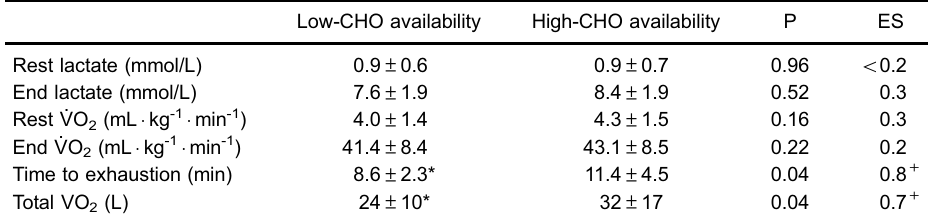
. Table 2. Values for lactate and VO 2 at rest and at the end of exercise, exercise time to exhaustion, and total VO 2 consumed during the